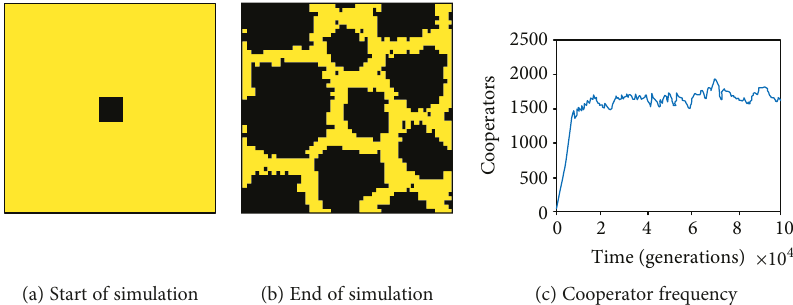
Figure 10: Evolution of cooperator frequency (black) when starting with an initial 6 × 6 cooperator cluster within a 50 × 50 grid of defectors (yellow).